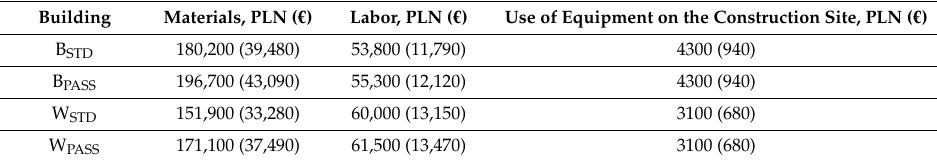
Table 4. The total cost of erecting a house depending on the type of